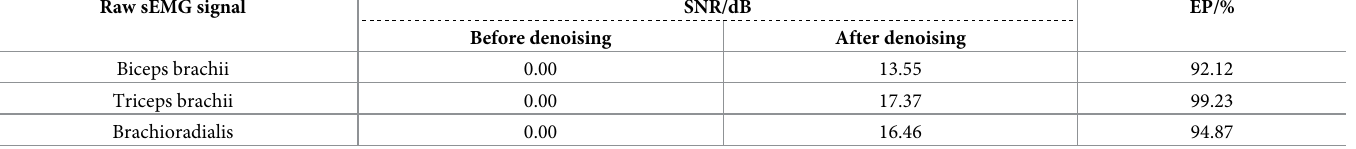
Table 2. Parameters of SNR and EP used for evaluating the denoising effect of biceps brachii, triceps brachii, and brachioradialis sEMG signals. Raw sEMG signal